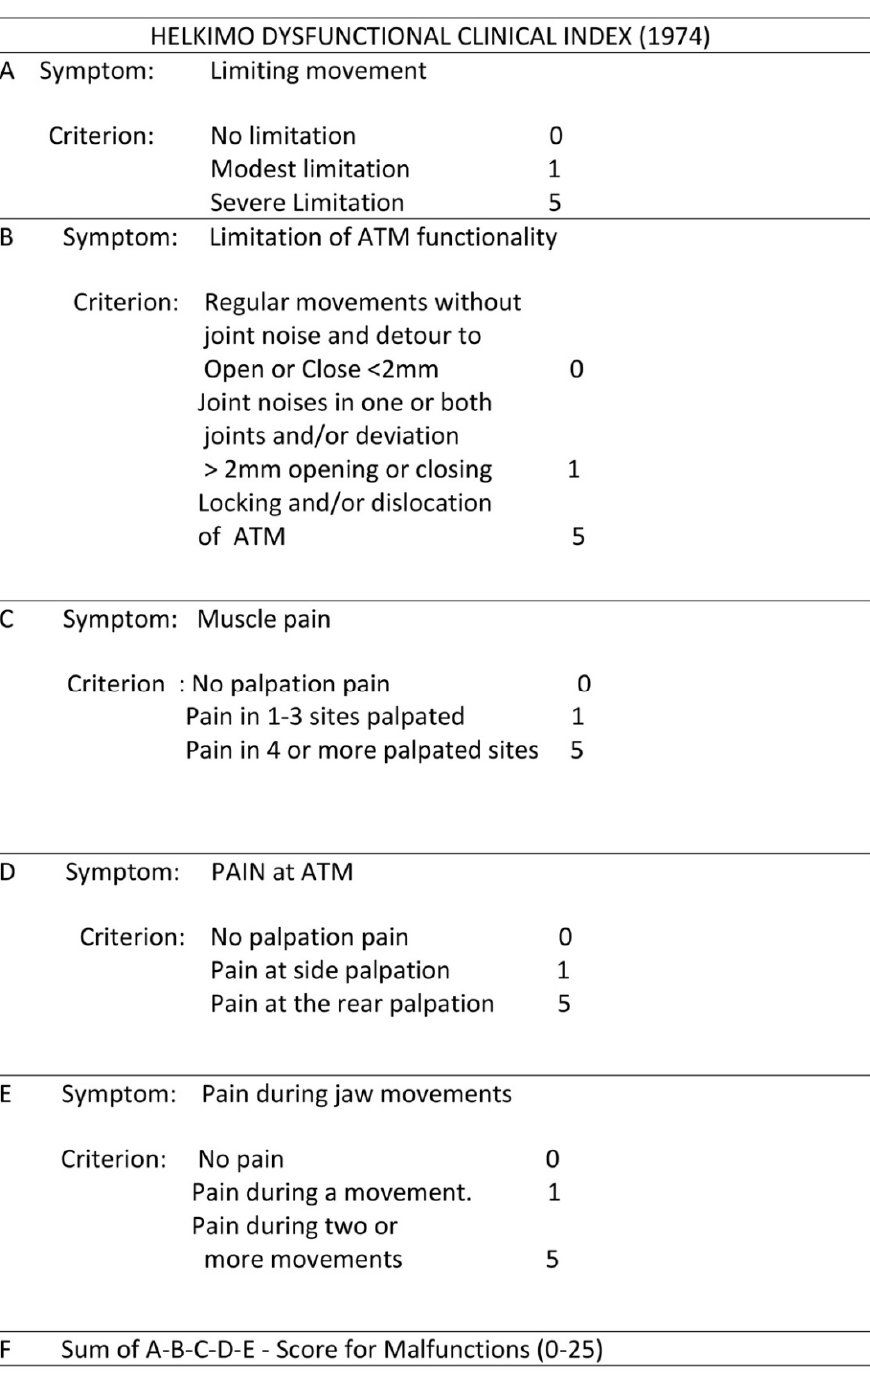
Figure 1. Helkimo clinical dysfunction index questionnaire.